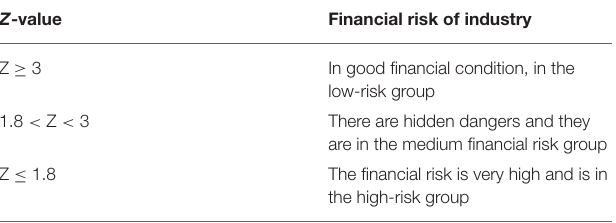
TABLE 3 | Regression results of R&D investment lagging behind phase